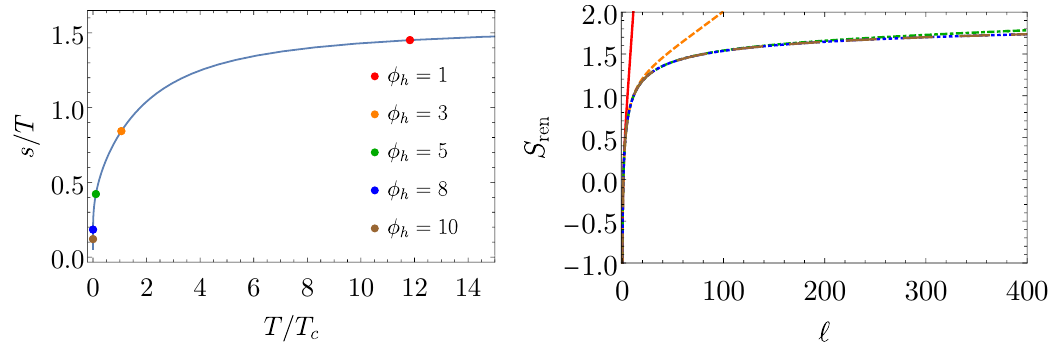
Figure 10 . Left panel: entropy density over temperature for crossover ( α = 0 ). The dots show the horizon value of the scalar field at each point, φ h = 1 , 3 , 5 , 8 , 10 . Right panel: EE computed by using the (5.16) for different black hole solutions as function of separation. Colors correspond to solutions marked with points in left panel.